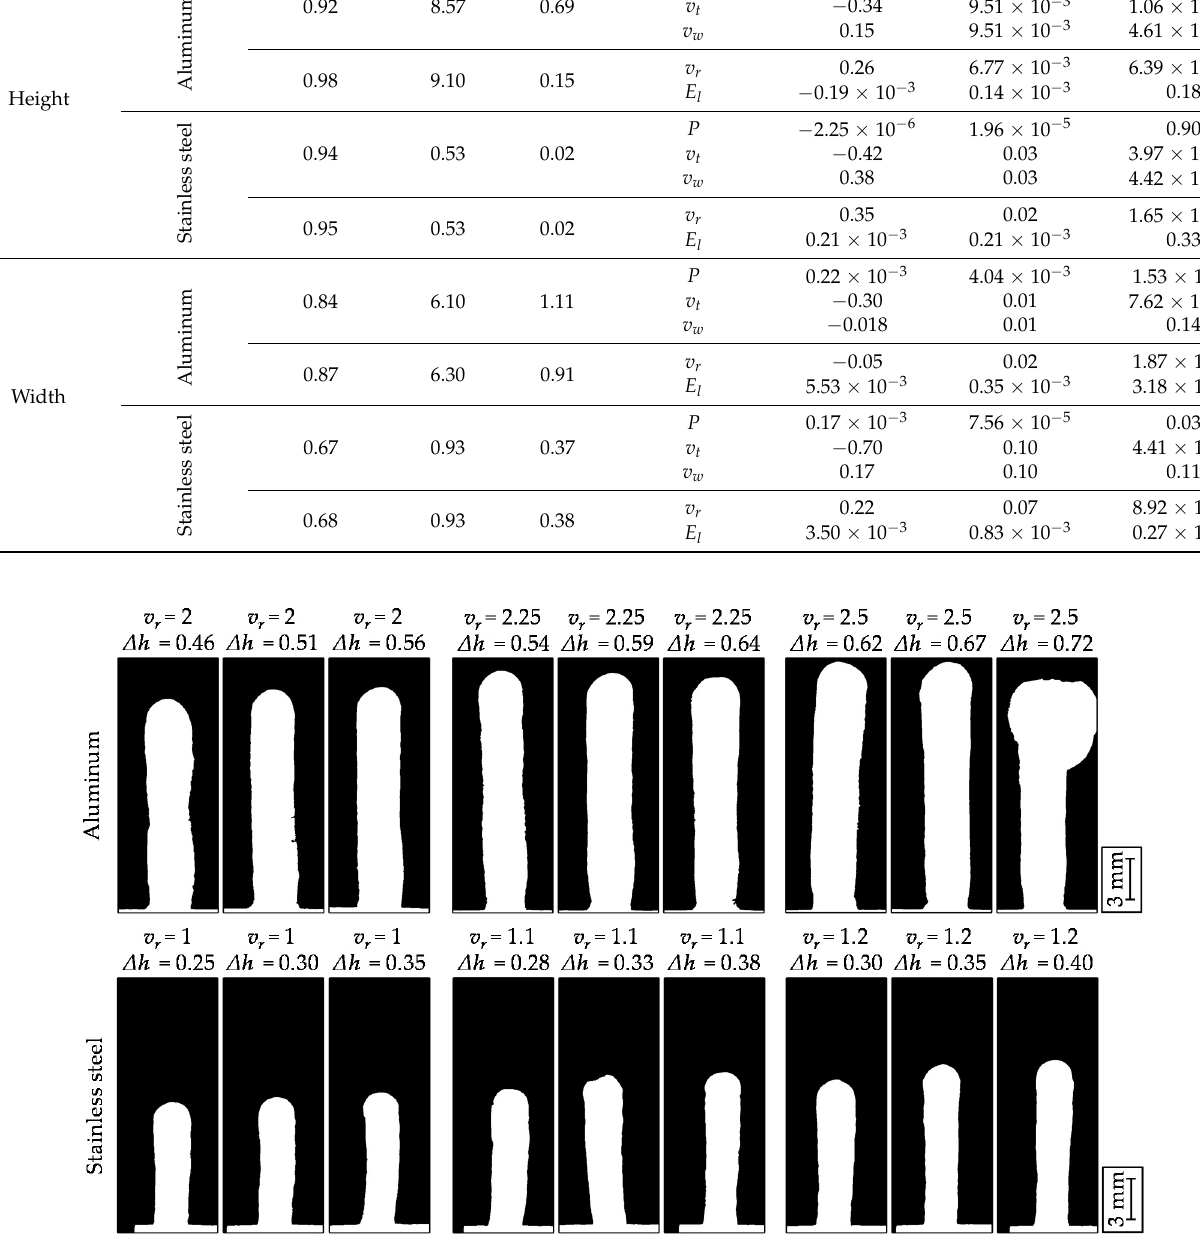
Table A1. Results of the ANOVA for the individual regression models.